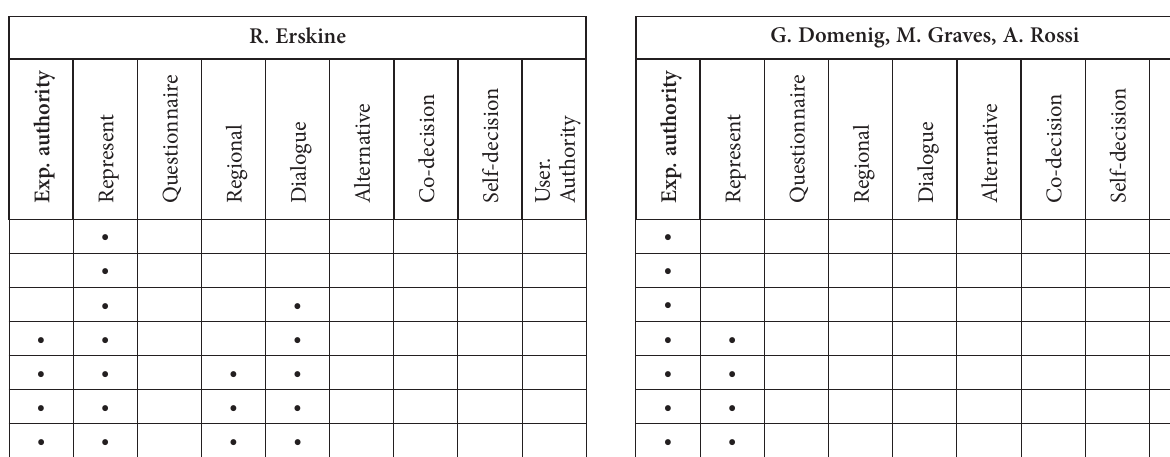
Table 1. Levels of design participation – works of Erskine (source: Wulz, 1986, p. 161 – Redraw: authors)